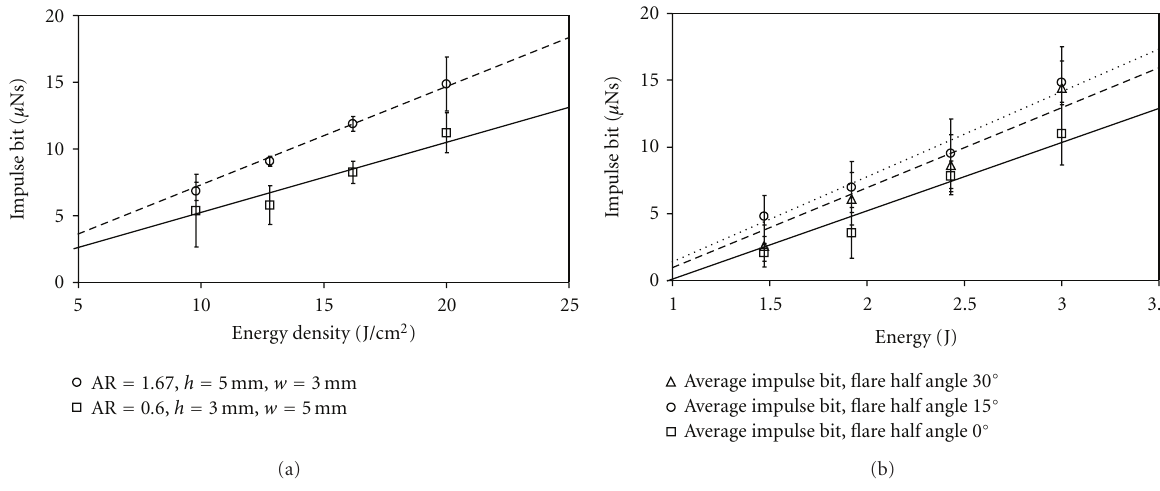
Figure 10: Experiment evaluation of µ PPT performance. (a) Varying with energy density at di ff erent AR. (b) Varying with energy at di ff erent flare half-angle.